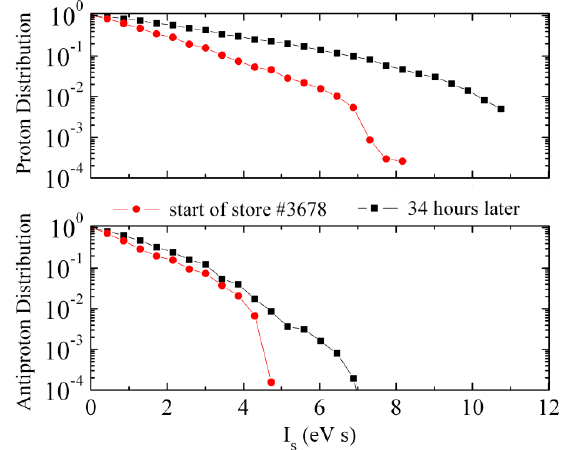
FIG. 5. (Color) The measured dependence of the normalized longitudinal phase space density on the particle action for the protons (top) and antiproton (bottom) at the beginning (red) and at the end (black) of store